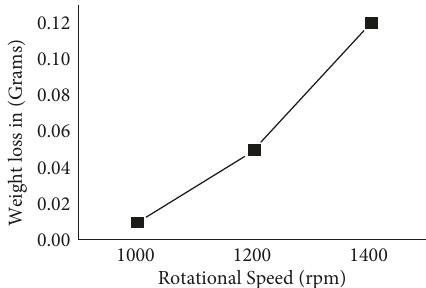
Figure 12: Corrosion resistance of the Cu-Br welded zone at various rotational speeds.